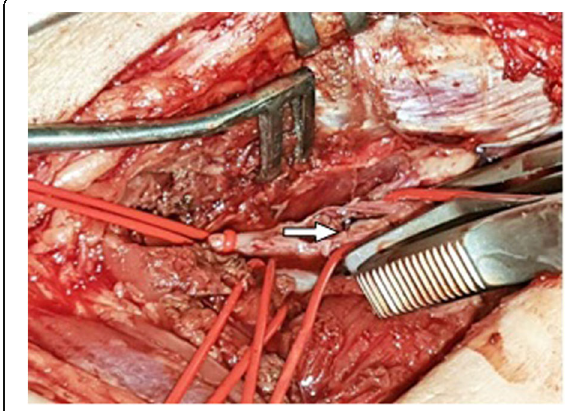
Fig. 3 Surgical exploration of the right TPT. The arrow points towards a metallic artifact revealed in the right TPT